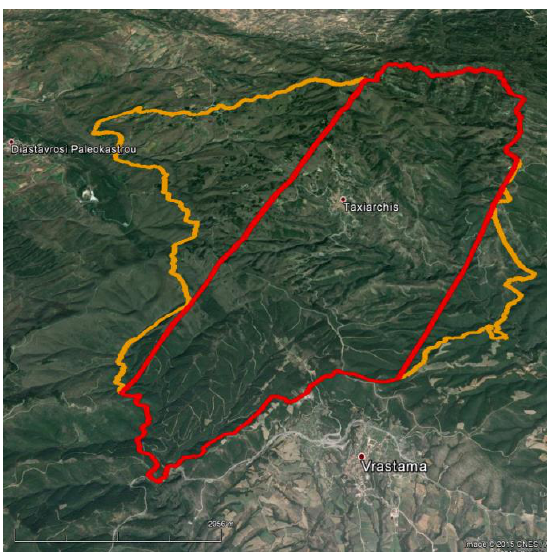
Figure 2. The University Forest of Taxiarchis (orange frame) and the area on which this study has focused (red frame) are presented. © Google Earth, Copyright 2015.